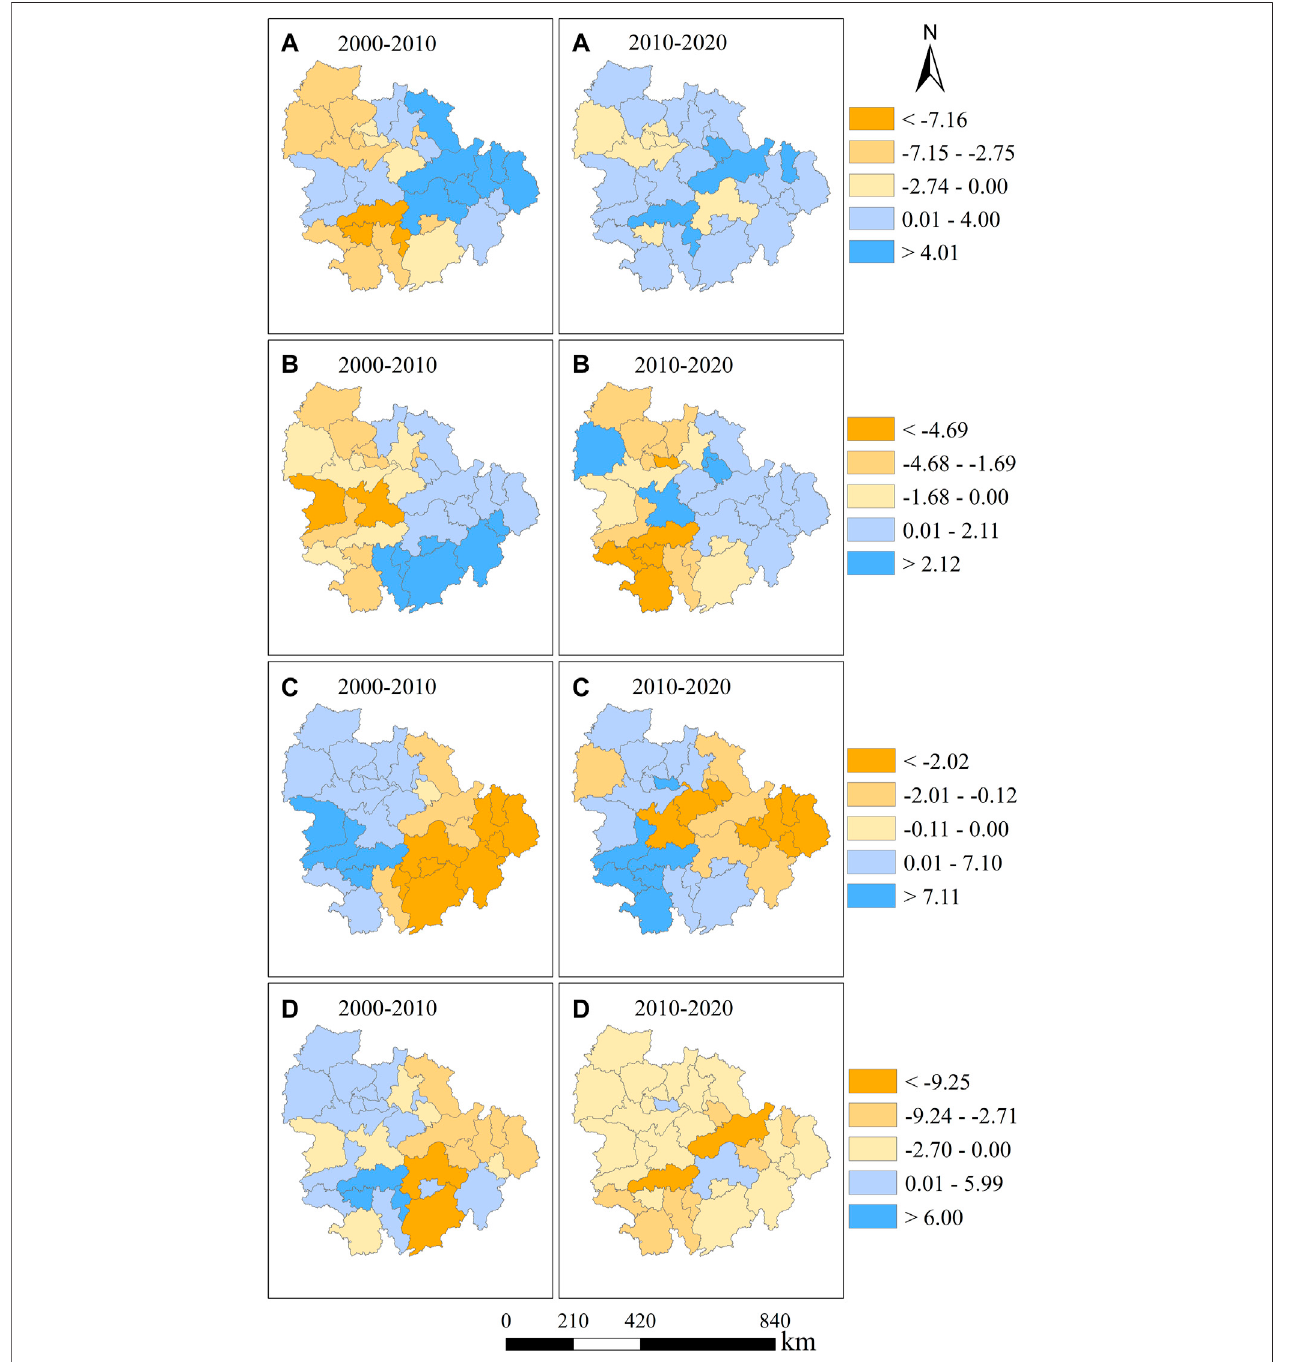
FIGURE 7 | Spatiotemporal distributions of the GWR coef fi cients of socioeconomic determinants in MRUA from 2000 to 2020: (A) GDP, (B) GDPF, (C) POP, and (D) INVEST.